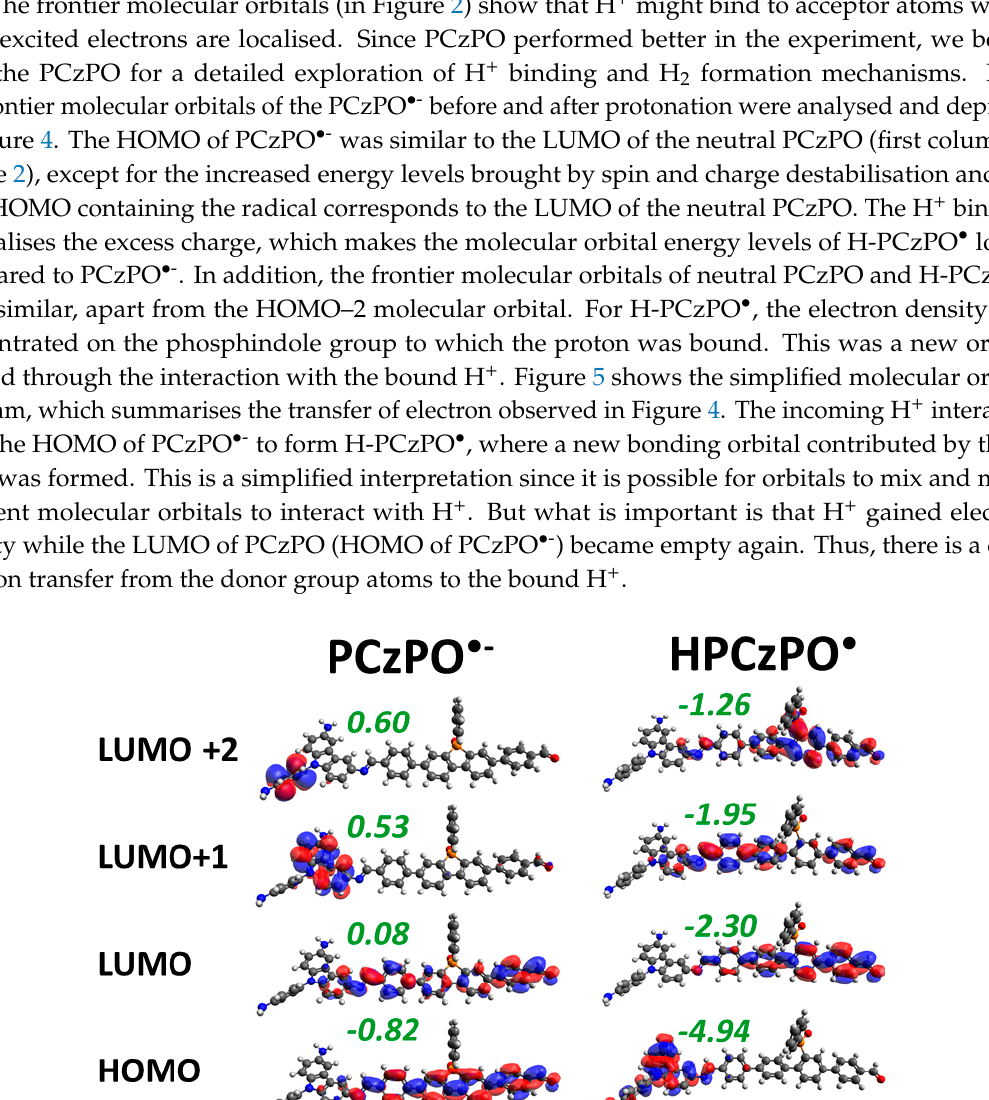
Figure 5. Molecular orbital diagram of the binding of a proton to PCzPO •- . The Mulliken charge of PCzPO •- was analysed to explore the various possible H + binding sites. The most negatively charged atoms of PCzPO were labelled accordingly in Figure 1 and listed in Table 3. In a previous DFT study of D-A polymers [10], electronegative heteroatoms were assumed as binding sites due to charge considerations. However, as seen in Table 3, even though N1 was one of the most negatively charged atoms, the H + binding to this site is the least favourable. This is because